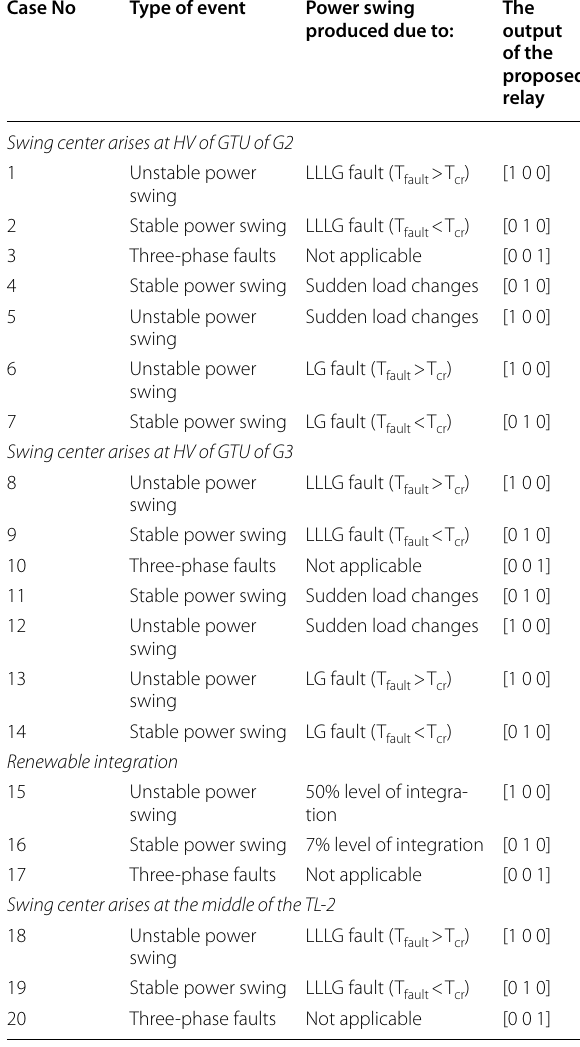
Table 6 Cases simulated to test relay logic for unknown